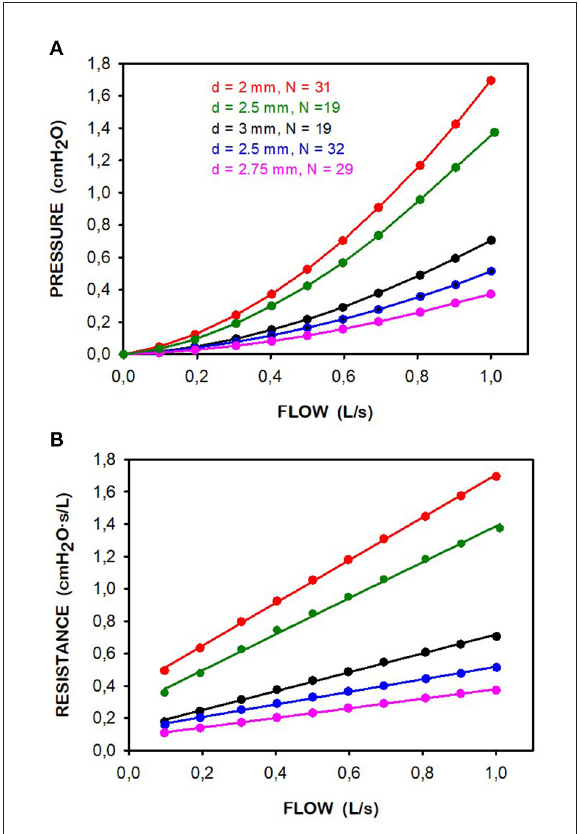
FIGURE3 Reference syringe-calibration of the 5 pneumotachographs constructed. (A) Relationship between pressure (P) an exhalation flow (V’). (B) Corresponding resistance (R) computed as R = P/V’. Points are measured data and lines correspond to fitting a Rohrer model (R = K 1 + K 2 · V’). In all cases the quality of the linear fitting was excellent ( r 2 > 0.9979). The computed K 1 and K 2 values are shown in Table 1. Data corresponding to pneumotachographs in Table 1 are in different colors. The legend indicates the diameter (d) and number (N) of drilled